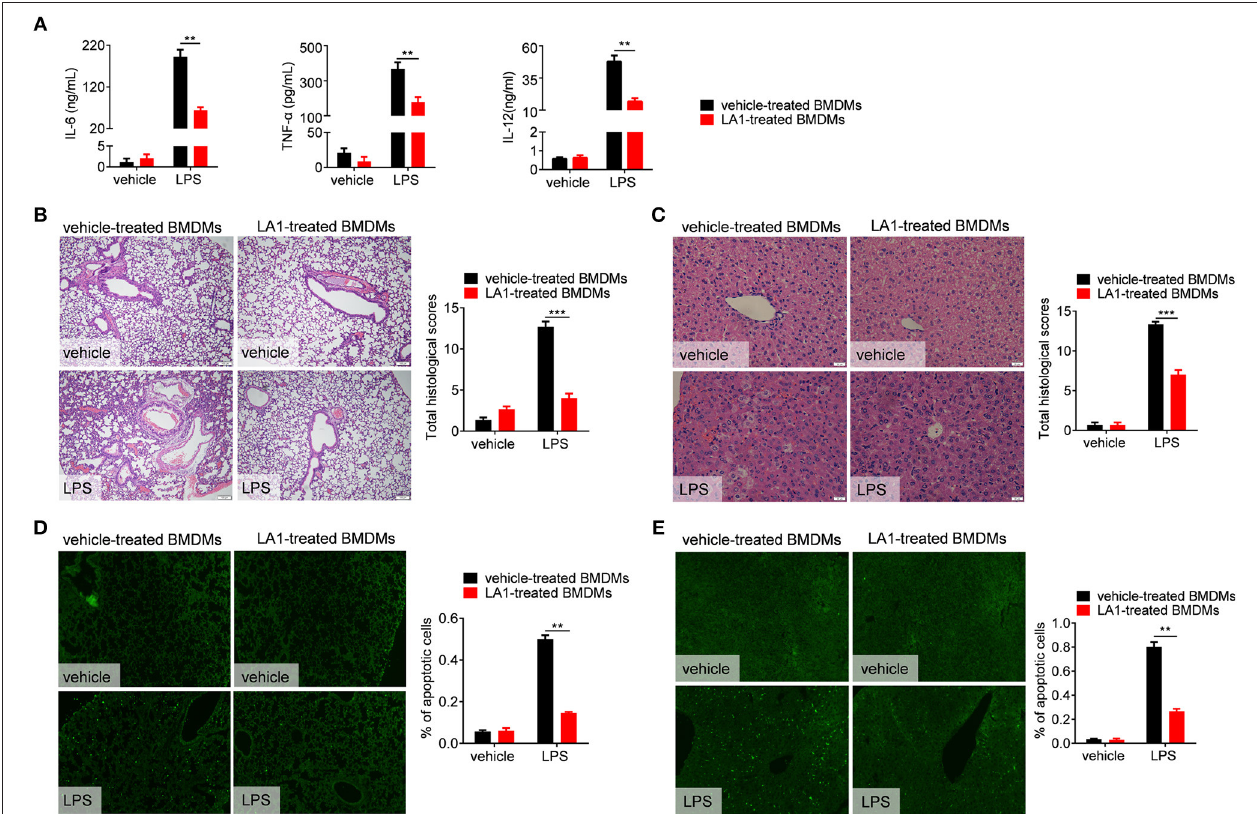
FIGURE 5 | LPS-induced inflammation was reduced in mice transferred with LA1- treated BMDMs compared with vehicle-treated BMDMs. BMDMs were treated with either LA1 (20 µ M) or vehicle for 2h before being injected into C57BL/6 mice (i.p.). After 12h, the recipient mice were stimulated with LPS (10 µ g/g of body weight). (A) Serum levels of IL-6, TNF- α , IL-12, and IL-1 β were determined by ELISA after 6h. Paraffin-embedded lung (B) and liver (C) sections were stained with H&E after 12h. Apoptosis in the cells of lung (D) and liver (E) were analyzed by TUNEL. Error bars represent S.E.M. ** p < 0.01, *** p < 0.001, as determined by two-way ANOVA post-hoc Bonferroni Multiple Comparison